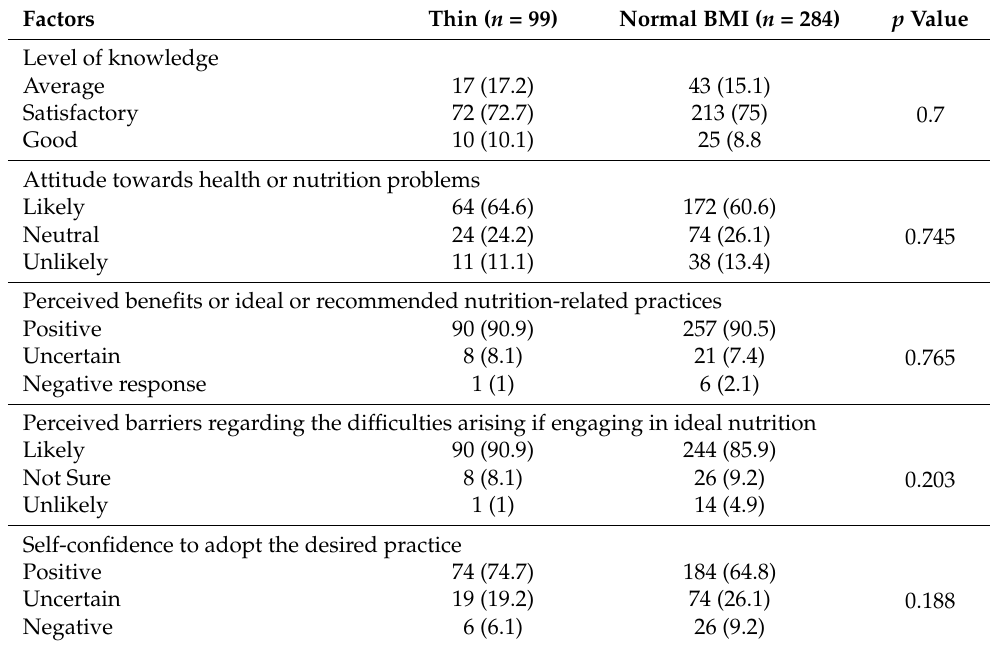
Table 6. Knowledge and attitude related to nutrition-related factors for thin and normal BMI